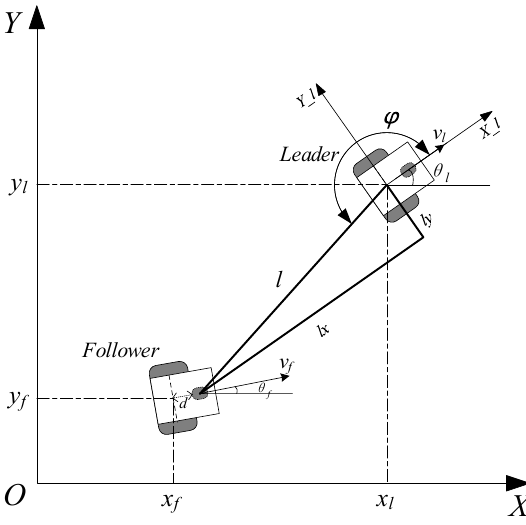
Figure 1. Vehicle models under the leader- follower method. In Figure 1, the X − Y coordinate system is the world coordinate system, and ( x l , y l ) and ( x f , y f ) represent the positions of the leader and the follower under this coordinate system, respectively. v l and v f represent the respective linear velocities, and θ l and θ f represent the forward direction angles of both, respectively. d represents the distance between the wheel axle and the guide wheel. l represents the distance between the midpoint of the leader wheel axle and the follower guide wheel. The coordinate system X _ l − Y _ l is established with the midpoint of the leader wheel axle as the coordinate origin, the forward direction of the leader vehicle as the X -axis direction, and the Y -axis direction perpendicular to the forward direction. l x and l y represent the relative distance from the follower to the leader in the X _ l , Y _ l directions, and ϕ represents the relative angle between the leader and the follower.